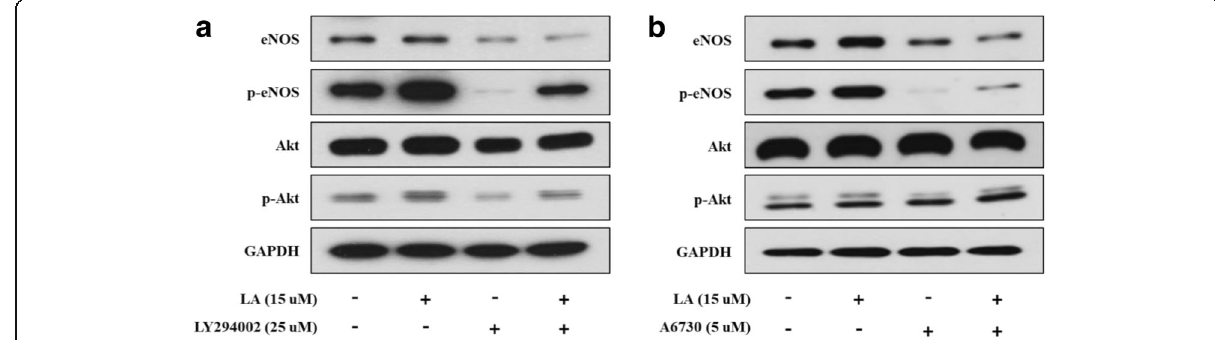
Fig. 4 Effects of LA on eNOS phosphorylation via the PI3K/Akt signaling pathway in HUVECs. HUVECs treated with LA (15 μ M) for 20 min and co- incubated with or without PI3K inhibitor (LY294002, 25 μ M) and an Akt phosphorylation inhibitor (A6730, 5 μ M) for 15 h. a Phosphorylation of eNOS and Akt was inhibited by LY294002; however, it was enhanced by treatment with LA, and ( b ) A6730 also suppressed the phosphorylation of eNOS and Akt, but their phosphorylation was improved by LA